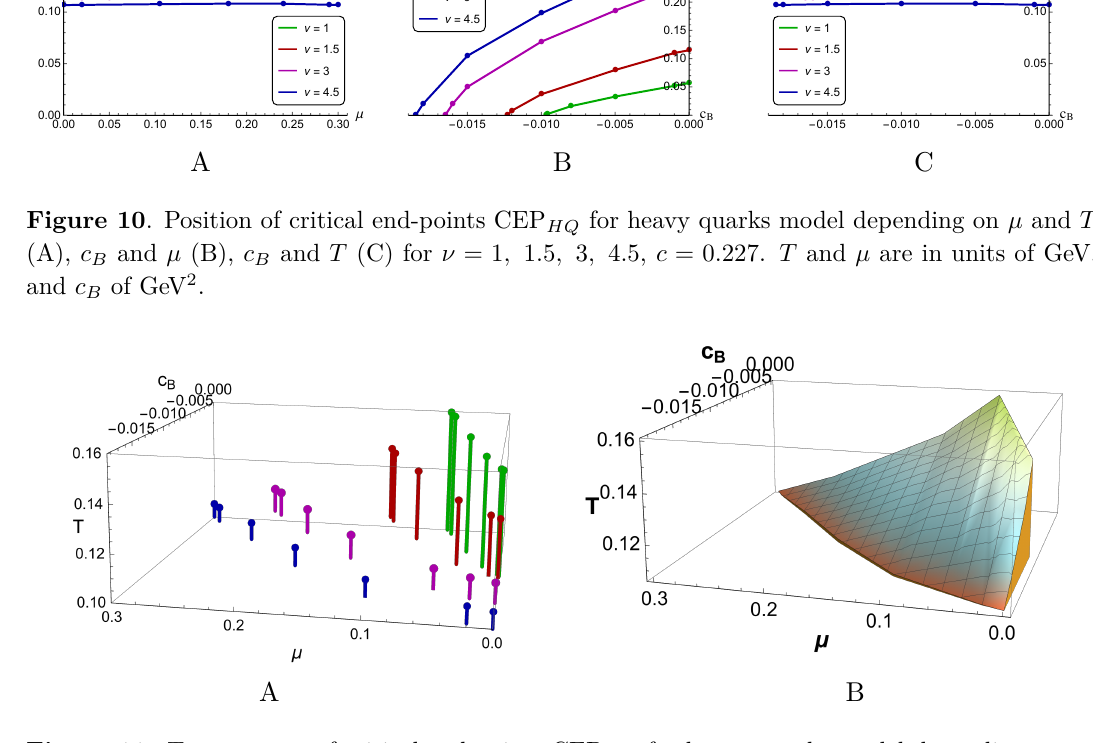
Figure 11 . Temperature of critical end-points CEP HQ for heavy quarks model depending on c B and µ for 1 ≤ ν ≤ 4 . 5 as a set of point (A) and as a 3D-surface (B), c = 0 . 227 . T and µ are in units of GeV, and c B of GeV 2